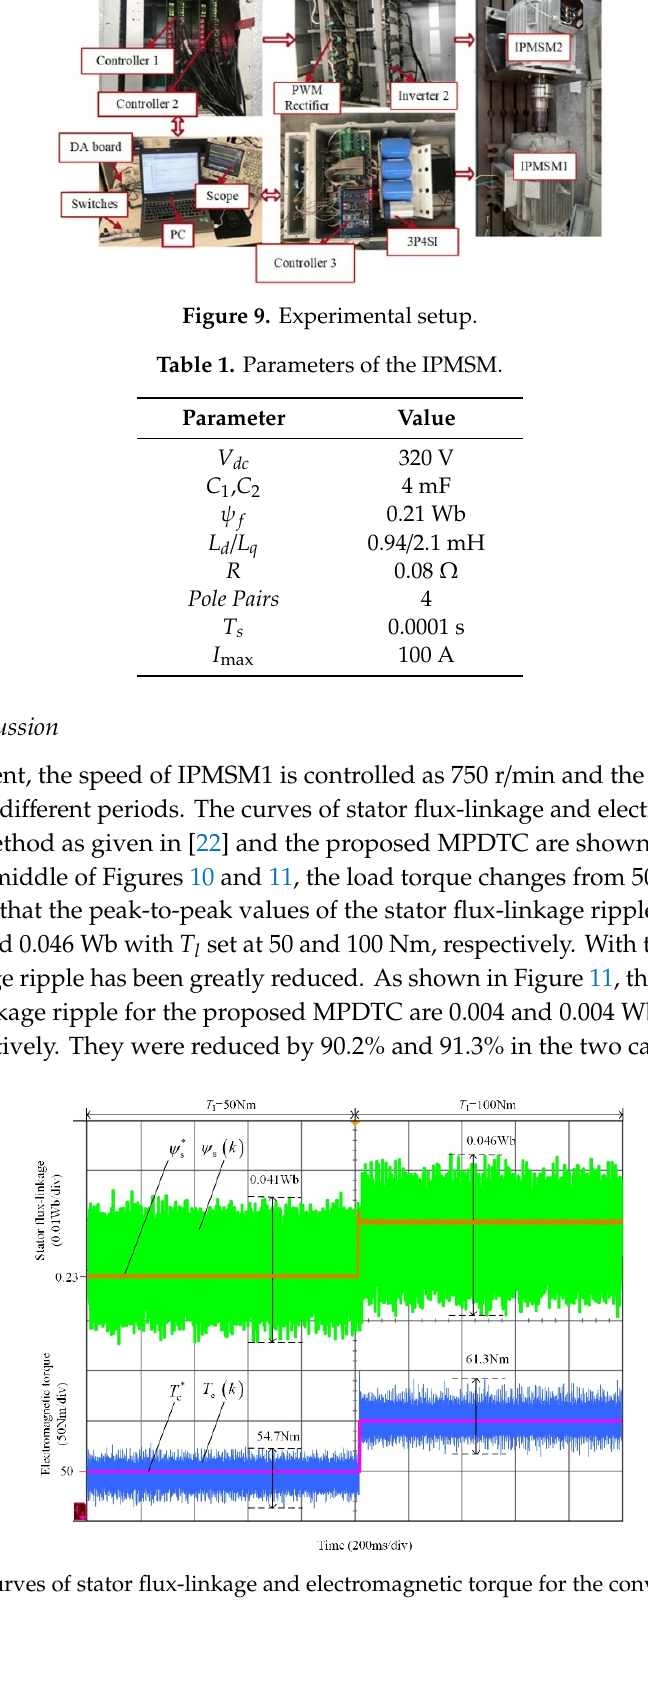
Figure 11. The curves of stator flux-linkage and electromagnetic torque for the proposed MPDTC. In addition, the peak-to-peak values of the electromagnetic torque ripple for the conventional MPDTC, as shown in Figure 10, are 54.7 and 61.3 Nm with T l set at 50 and 100 Nm, respectively. With the proposed MPDTC, the electromagnetic torque ripple was also greatly reduced. As shown in Figure 11, the peak-to-peak values of the electromagnetic torque ripple for the proposed MPDTC are 5.1 and 5.1 Nm with T l set at 50 and 100 Nm, respectively. They were reduced by 90.7% and 91.7% in the two cases. In addition, both the stator flux-linkage and electromagnetic torque can be fast tracked in the load sudden change case, and thus the proposed MPDTC has an excellent dynamic performance. The curves of the phase current with T l set at 100 Nm for the conventional and the proposed MPDTC are shown in Figures 12 and 13, respectively. It is obvious that the current ripples were greatly reduced. The spectra of the phase current are shown in Figures 14 and 15. For the conventional MPDTC, the total harmonic distortion (THD) of the phase current is 10.35%, and it was reduced to 4.14% with the proposed MPDTC method. As shown in Figure 14, the harmonic components of the